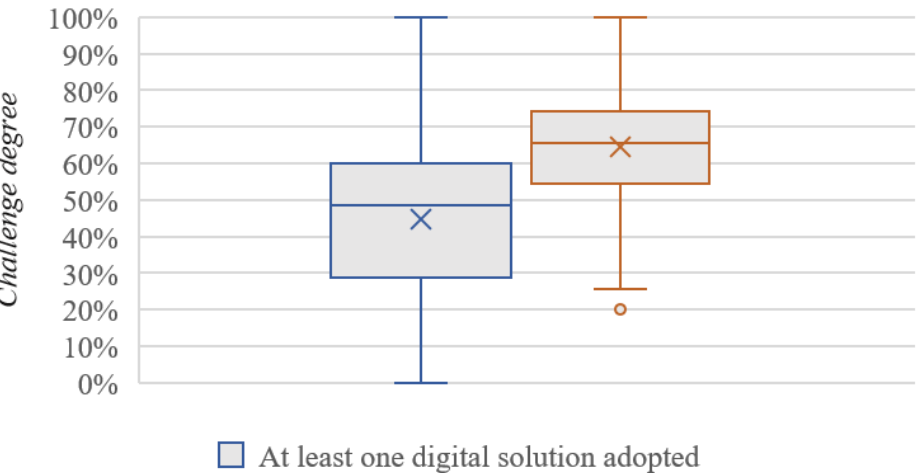
Figure 13. Boxplot graph of level of challenge between users and nonusers.